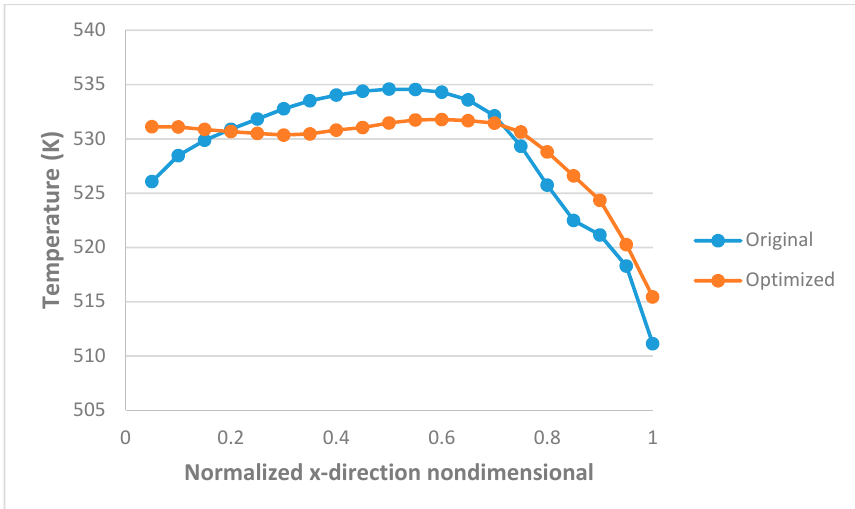
Figure 11. Temperature distribution comparison at the outlet.